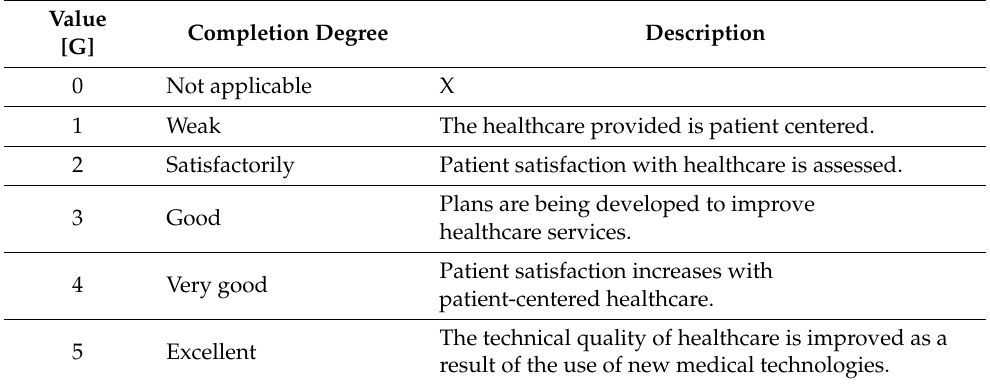
Table 8. Indicator evaluation grid P.B.2—Interventions with positive effects on patient satisfaction.